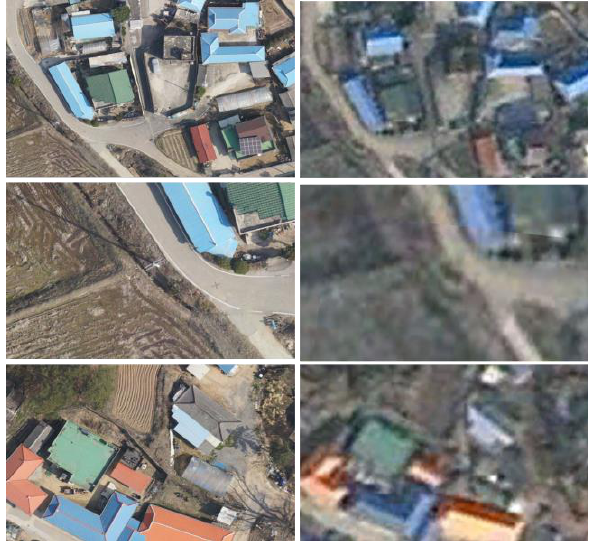
Figure 9. Orthoimages produced by our software (left) and served by Google Earth (right)